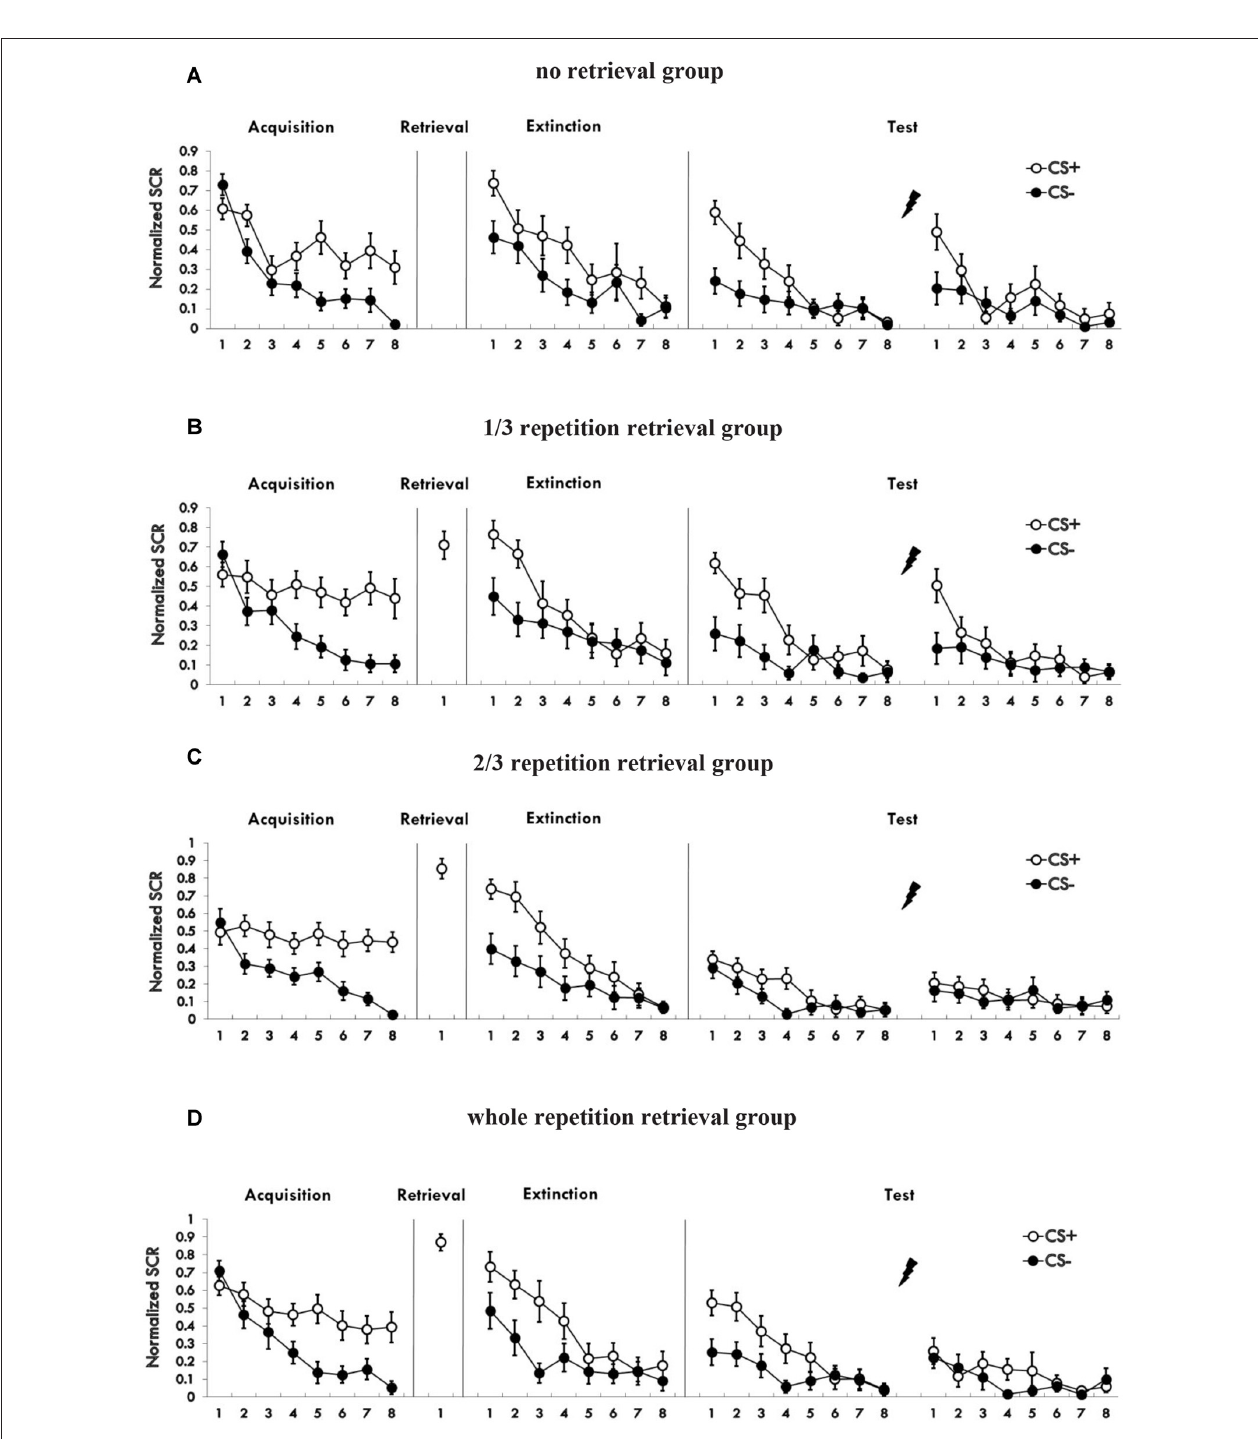
FIGURE 2 | (A–D) Mean skin conductance responses (SCRs) to the CS+ and CS − trials during acquisition, reactivation, extinction and spontaneous recovery test and reinstatement test in each group.